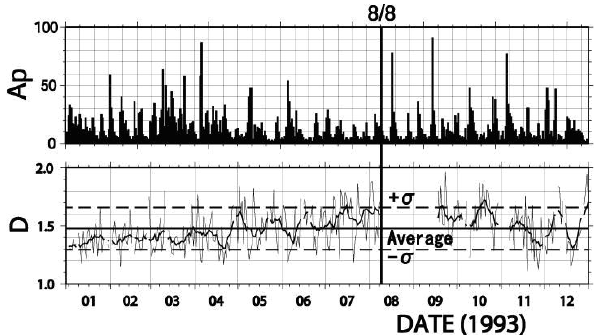
Fig. 6. Temporal evolution of mono-fractal dimension (D) during one whole year of 1993 (bottom panel). The day of EQ is indicated by a vertical line with the notation of 8/8 (8 August). The upper panel indicates the geomagnetic activity expressed by Ap index. Daily D value is given in a thin line and the average value running over ± 15days is given by a thick line. The average D value over the whole period is indicated by a horizontal line and the ± σ ( σ : standard deviation over the whole period) lines are given in broken lines. After Ida and Hayakawa (2006) and Hayakawa and Ida